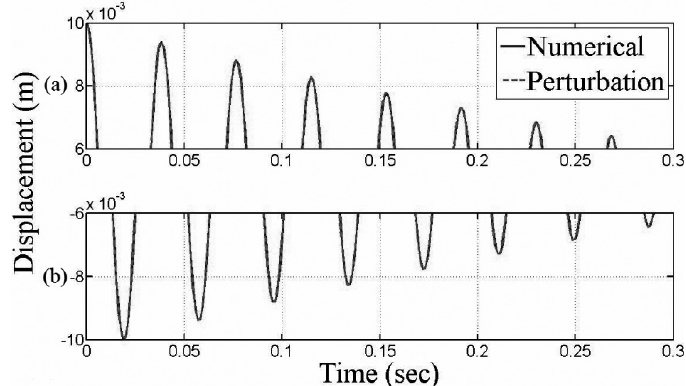
Fig. 5. (a) Responses obtained through the perturbation method ( − − − ) and numerical method ( ) in (a) upper half cycles, (b) lower half cycles.